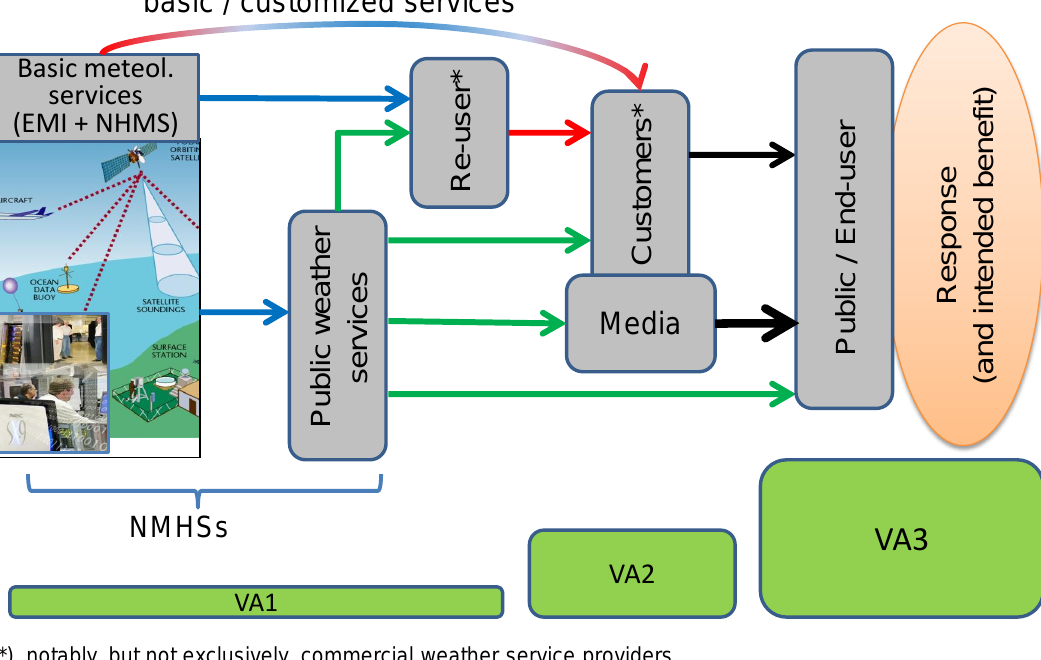
Figure 1. Principal stages in the provision of meteorological services and the related generation of value added by stage; VA = value added (by service stage 1, 2, 3).